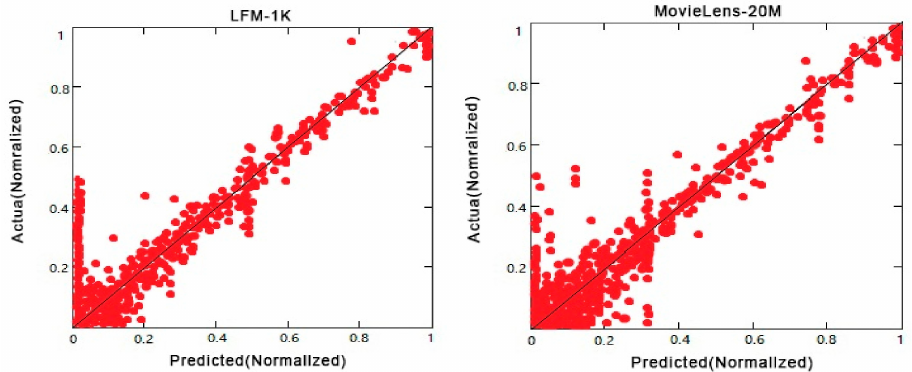
Figure 9. Comparison of actual ratings and predicted